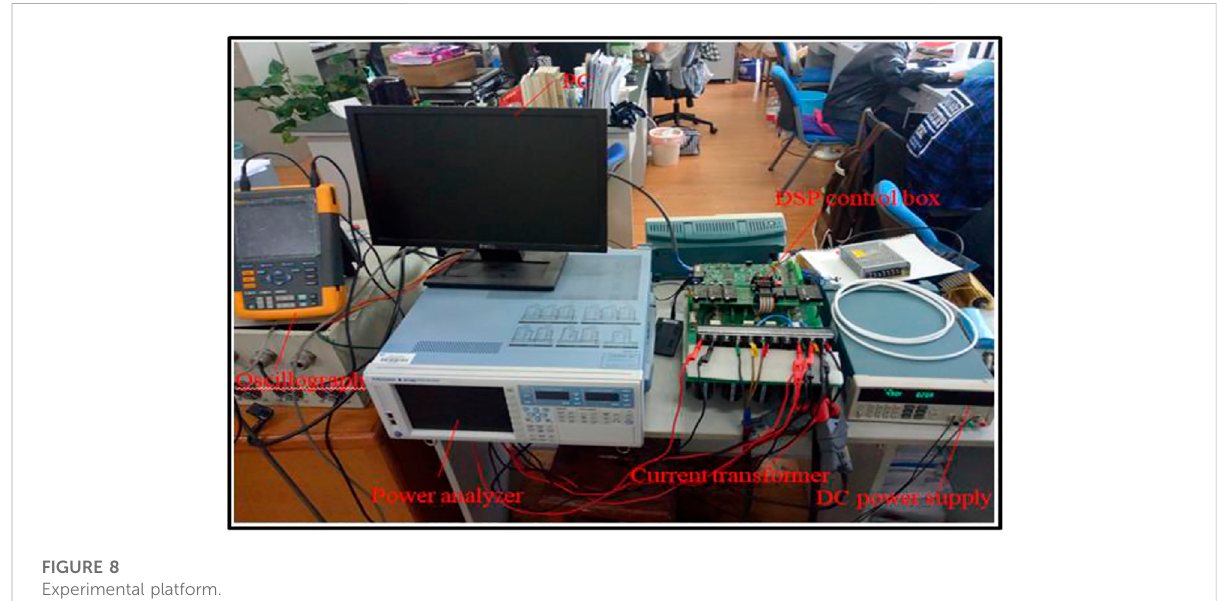
FIGURE 8 Experimental